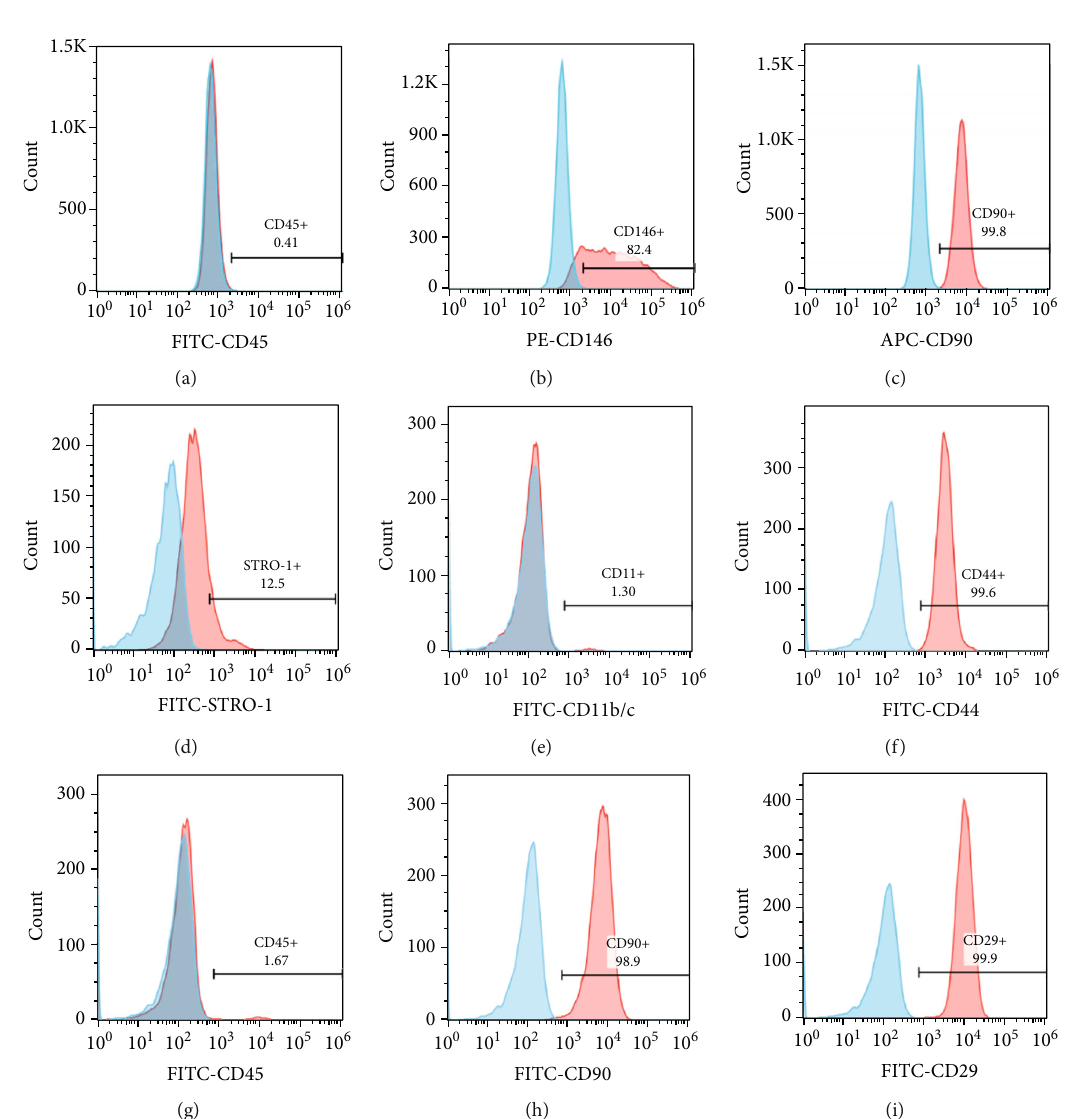
Figure 1: Identi fi cation of hPDLSCs and rBMSCs: (a – d) fl ow cytometry analysis of the surface markers of PDLSCs; (e – i) fl ow cytometry analysis of the surface markers of